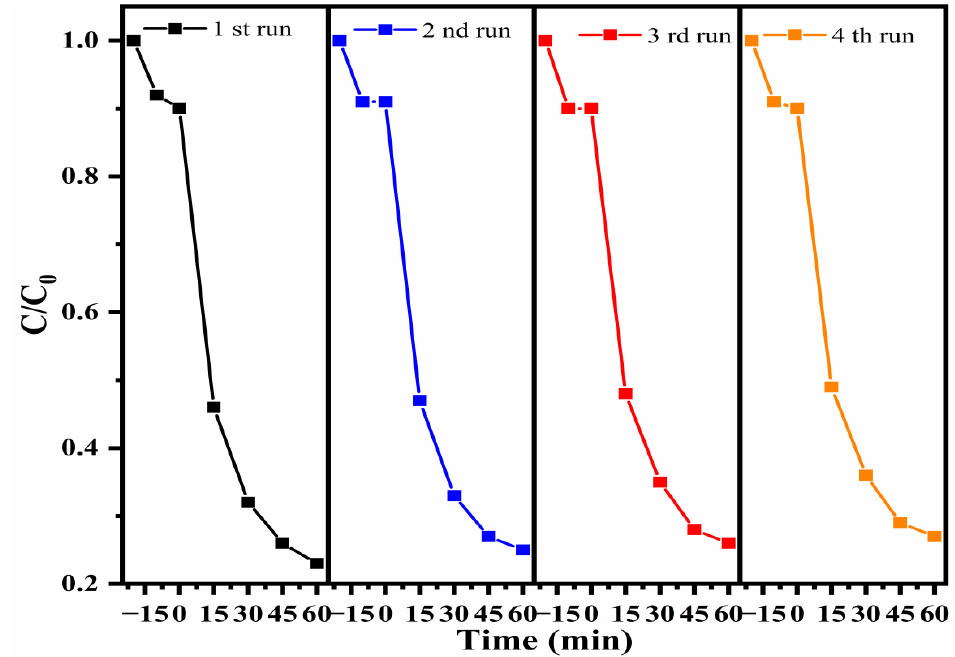
Figure 11. Cycling experiment of TC-HCl degradation catalyzed by 30% PCNS/BWO.